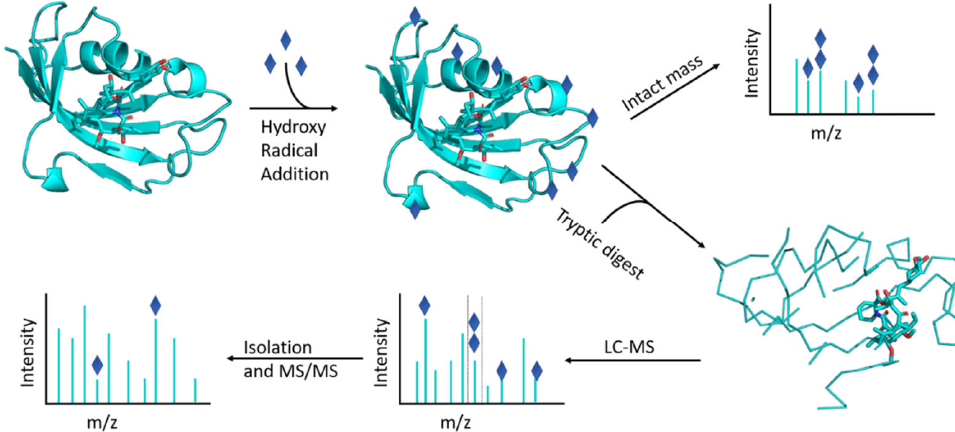
Figure 1. Schematic representation of the oxidative footprinting workflow.